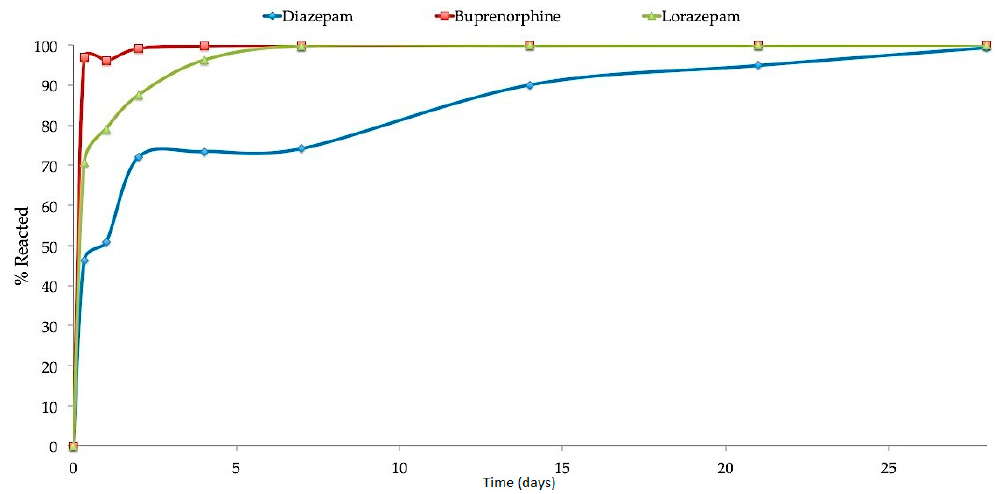
Figure 9. Deactivation profile of diazepam, buprenorphine and lorazepam.